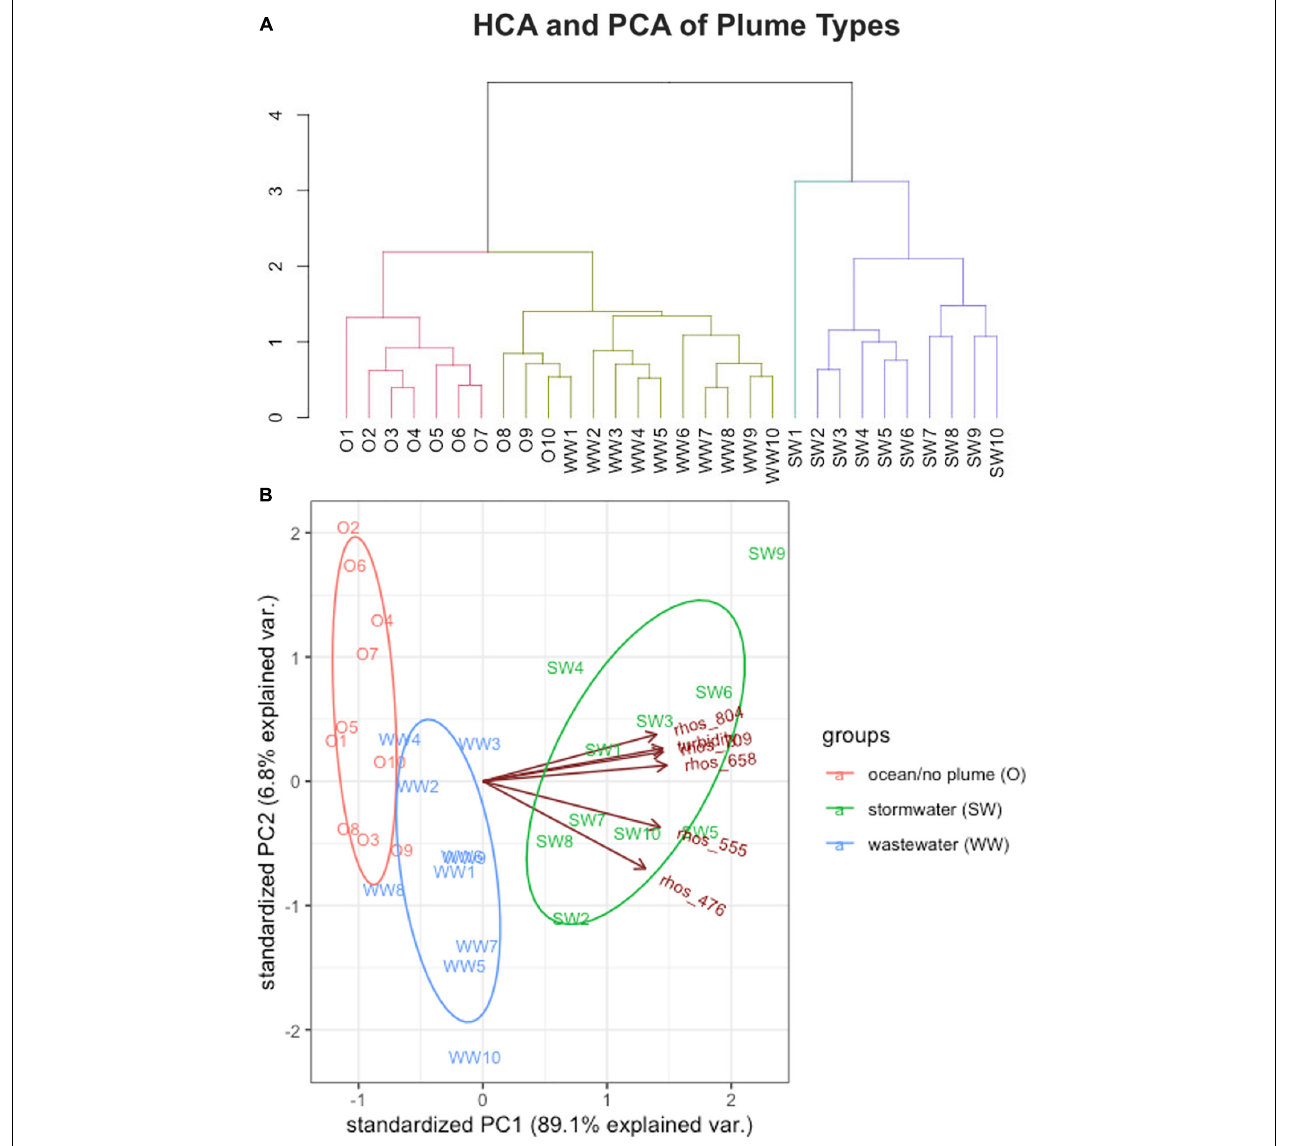
FIGURE 4 | HCA and PCA Analysis. (A) A dendrogram tree from the HCA. (B) PCA result of PC1 on the x -axis, and PC2 on the y -axis. The arrows indicate the relative influence of the parameters used in the underlying data (surface reflectance and derived